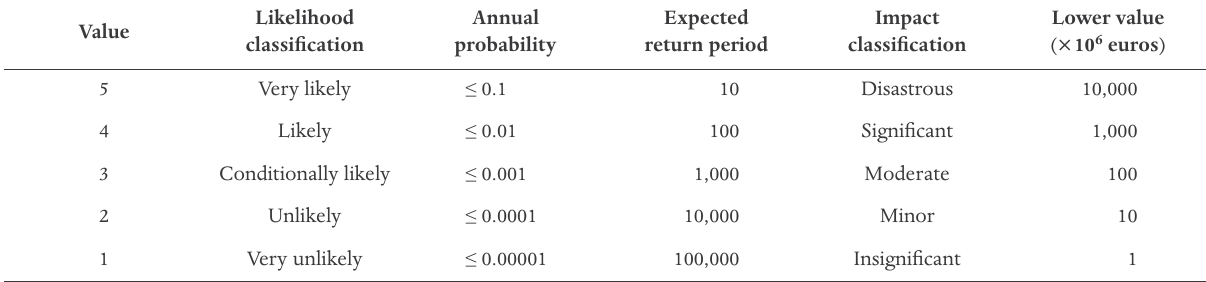
Table 1. The bounding limits for the risk matrix presented in Figure 2 (for the likelihood, see Table 3 in BBK [2011], for the terms of likeli- hood and impact, see Figure 1, BBK Figure 2 the combination of the three risks probabilities that give an approximate loss of € 100 million/annum.